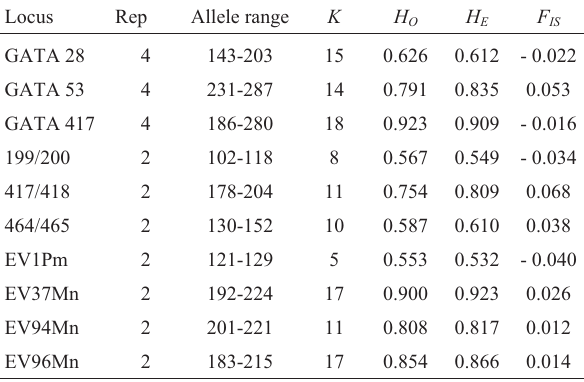
Table 1 - Prior values (minimum and maximum, with uniform distribu- tion) for the parameters used for the four demographic scenarios (Figure 2a) in the DIYABC approach. Effective sizes are in number of individuals and times are in number of generations (generation time of 18 years). Scenario/Parameter